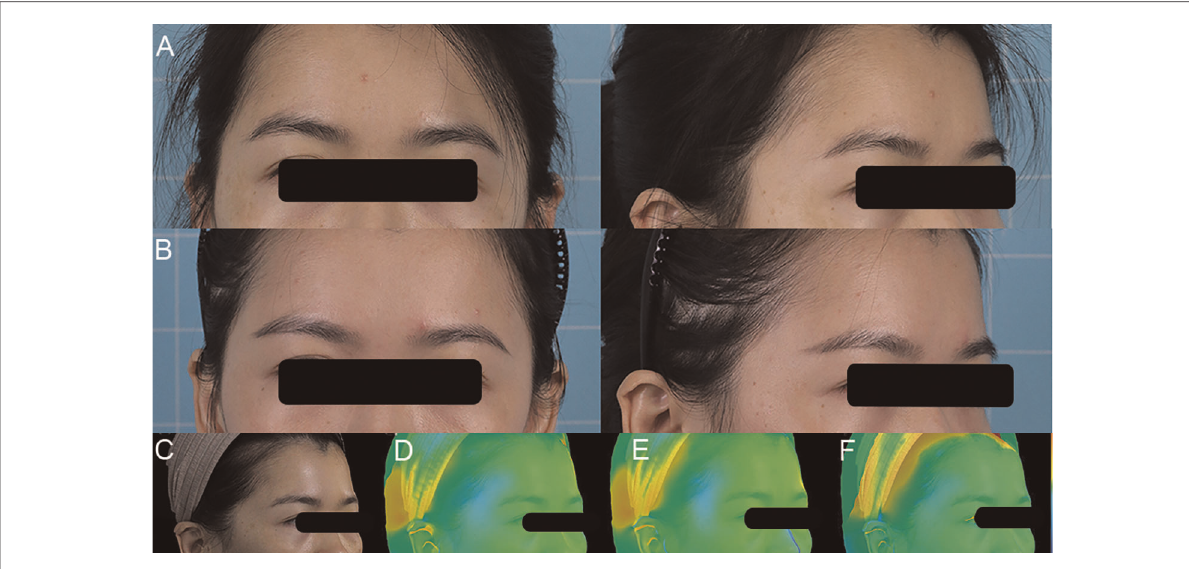
FIGURE 6 A 23-year-old female patient presented with temple hollowing and was treated with Coleman ’ s fat grafting. ( A ) Preoperative front and right oblique photos. ( B ) Preoperative front and right oblique photos at 12 months after one Coleman ’ s fat grafting procedure. ( C ) Preoperative right oblique photo. ( D – F ) 3D reconstruction of right oblique images at 1, 6, and 12